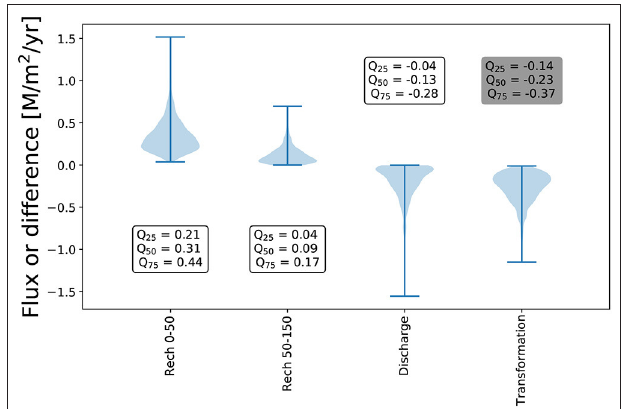
FIGURE 5 | Fluxes through the boundaries and the difference between input and output attributed to the transformation for 1,000 model realisations.